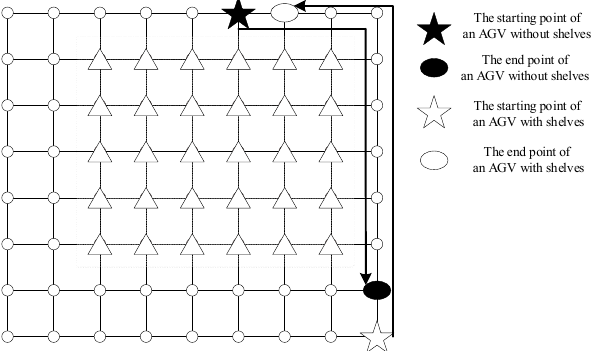
Figure 7. Path planning of AGV based on the classic A* algorithm.